Question: From the figure, is the trend upward or downward?
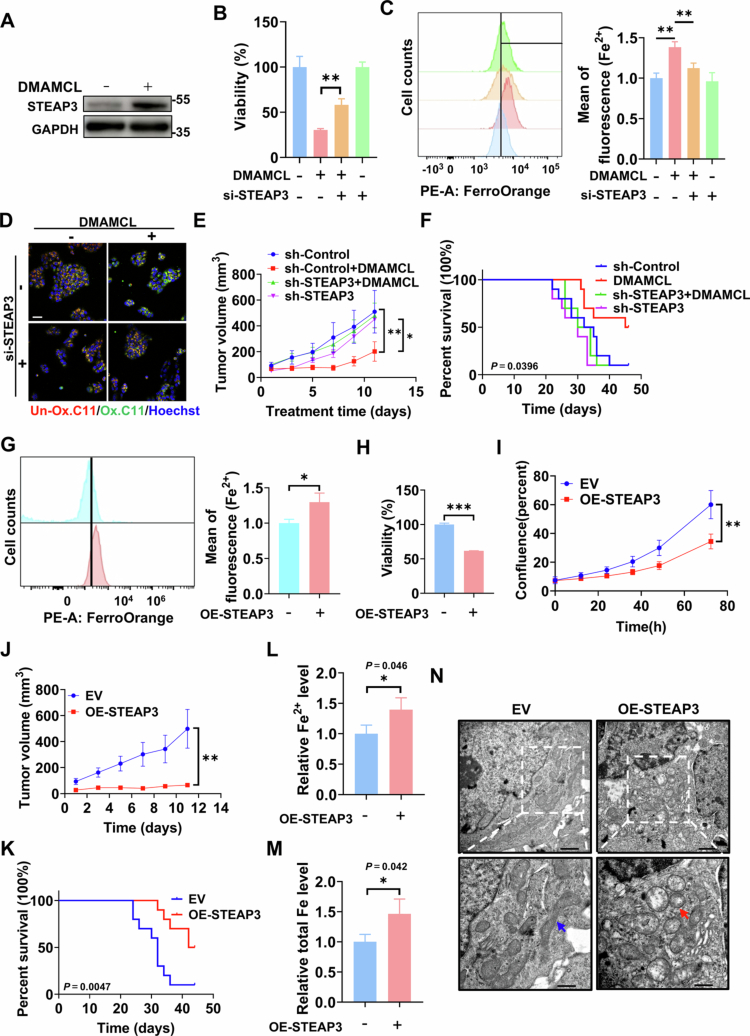
Answer: increasing